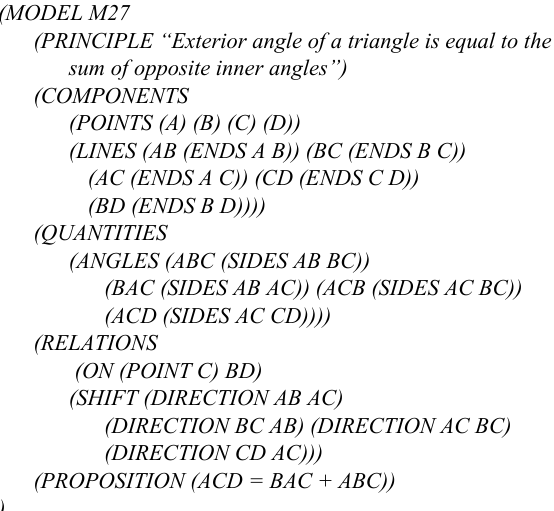
Fig. 1b. A model corresponding to the principle in Fig.